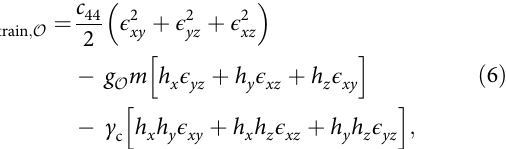
values of the Landau parameters used for Fig. 1.